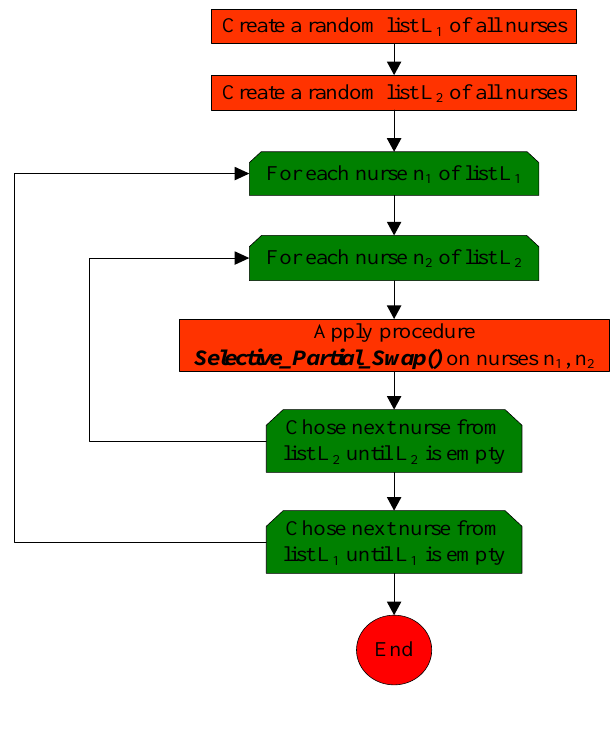
Figure 7. The structure of the procedure, Random_Segment_Swap_Mutation